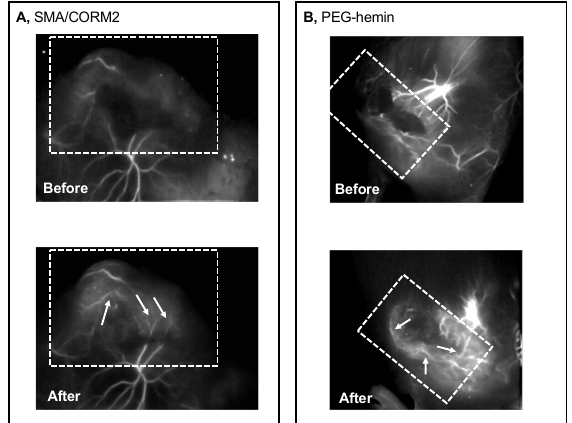
Figure 6. Improvement of tumor blood flow by SMA / CORM2 ( A ) and PEG-hemin ( B ), as indicated by fluorescence angiography. The S180 tumor-bearing mice with tumors of 15–20 mm in diameter were examined, and the angiography were performed immediately after the i.v. injection of the fluorescence nanoprobe using a SAI-1000 in vivo imaging system. After 24 h of nanoprobe injection i.v., SMA / CORM2 (10 mg / kg) or PEG-hemin (10 mg / kg, hemin equivalent) was administered i.v. After a scheduled time (2 and 24 h, respectively), the fluorescence nanoprobe was applied and an angiogram was obtained as described above. The dashed lines indicate the approximate area of the tumor, and the arrows indicate fluorescently visualized tumor blood vessels. The visuality of the blood vessels is very weak before the injection of CO generators (Before in ( A ) and ( B )), compared with those after infusion of CO generators (After in ( A ) and ( B )). See text for